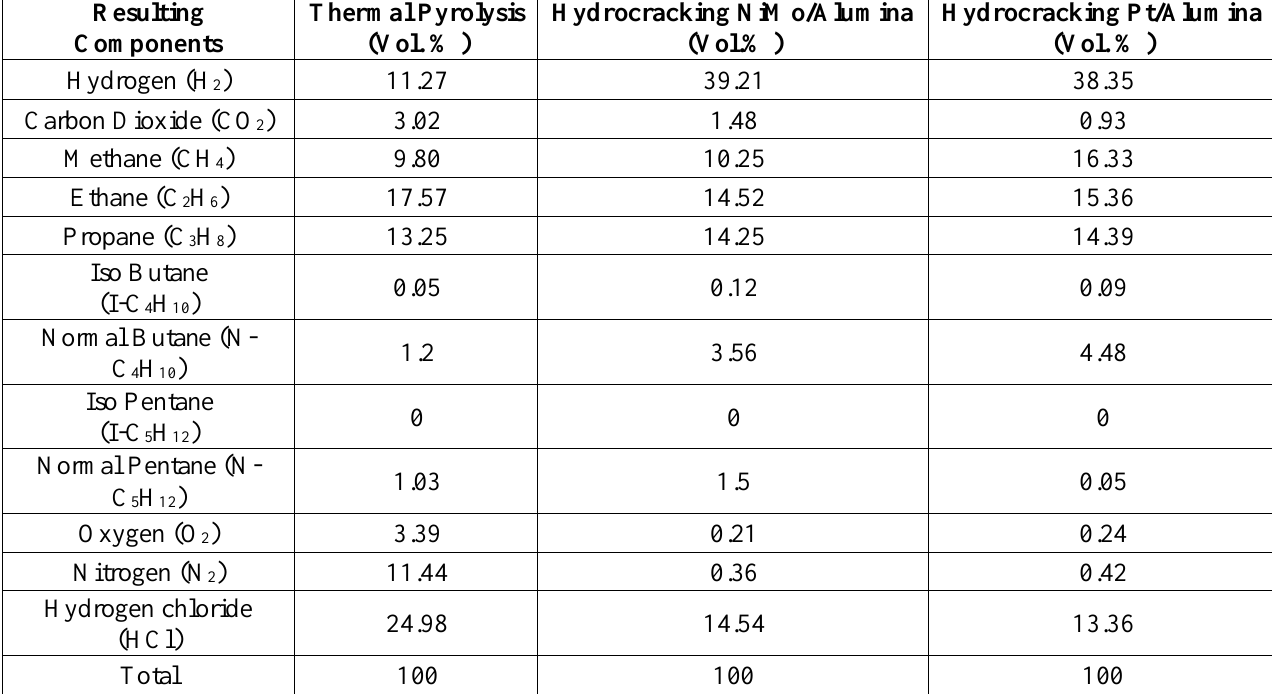
Table 3: The proportions of hydrocarbons Product in the gas